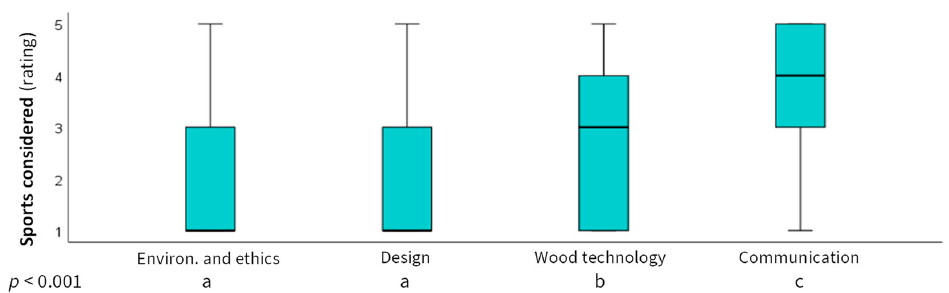
Figure 2. Results of the evaluation of the four considered dimensions, and grouping (a–c) based on statistical analysis.